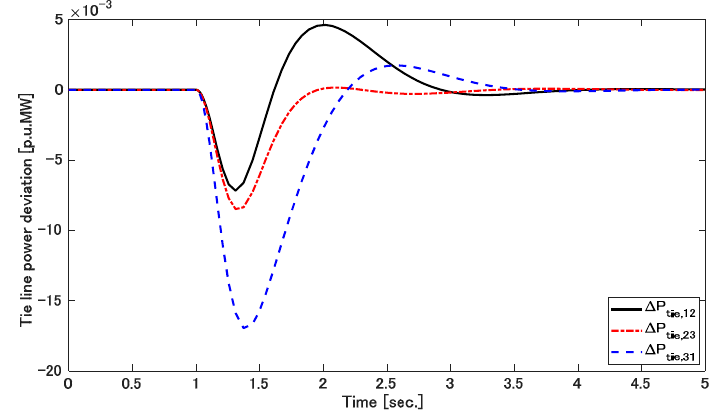
Figure 5. Tie-line power of three-area power system.